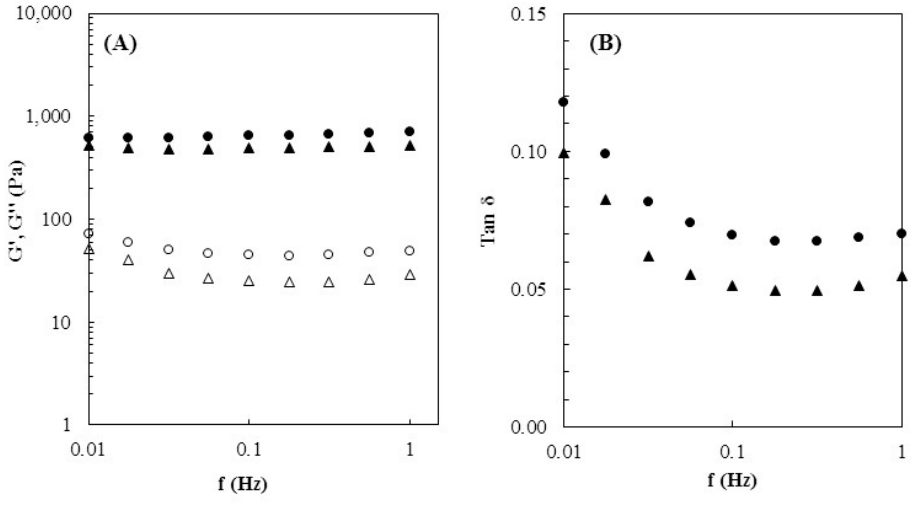
Figure 4. Rheological properties of the Na5 1 * 4 ( ) and Na5 1 * 6 ( ) hydrogels at 25 °C: ( A ) Mechanical spectrum storage (G ′ , solid symbols) and loss moduli (G ″ , open symbols), ( B ) loss tangent (tan δ ). The Na5 1 * 6 hydrogels exhibited higher values of both G ′ and G ″ across the entire range of frequencies (Figure 4A), which can be related to their higher polymer content. For a frequency of 1 Hz, the Na5 1 * 6 hydrogels presented a G ′ of 702.25 ± 28.65 Pa, while lower values were reached for the Na5 1 * 4 hydrogels (523.20 ± 21.08 Pa), as well as for the Na5 1 * hydrogels (149.9 ± 9.8 Pa) [24]. This behavior can be explained by the denser cross- linked structure the Na5 1 * 6 hydrogels formed (Figure 1C) due to the higher polymer con- centration and has been reported for other CGC-based hydrogels. An example are the hydrogels prepared with Ganoderma lucidium CGC dissolved in ionic liquids [39], for which the authors reported a gel strength increase (from ~3500 to ~7000 Pa, at 1 Hz) by increasing the polymer concentration from 4 to 6 wt%. The viscoelastic behavior of CGC hydrogels was also determined by the value of the loss tangent of delta (tan δ ), which represents the ratio of energy lost to energy stored during deformation. As shown in Figure 4B, both hydrogels exhibited tan δ values below 1, which confirms the elastic characteristics of CGC hydrogels [40]. Moreover, it can be observed that by increasing the frequency a decrease in the tan δ values was achieved, and for both hydrogels, a plateau was reached. This behavior is associated with the mostly frequency-independent performance of both moduli (Figure 4A). Similar behavior was reported for chitosan-based hydrogels [41]; however, those structures were weaker than CGC hydrogels since higher tan δ values (above 0.15) were obtained. Over the whole range of frequencies, the Na5 1 * 4 hydrogels presented lower tan δ values (0.049–0.100) com- pared to Na5 1 * 6 hydrogels (0.067–0.118). The results indicate that during deformation, Na5 1 * 4 hydrogels have more elastic characteristics, which give them a higher ability to store energy than to dissipate it. These findings are in accordance with the mechanical properties and revealed that increasing the polymer content led to the fabrication of more rigid hydrogels. 3.5. Swelling Ratio and Water Retention Behavior The swelling ability of CGC hydrogels was assessed by immersing freeze-dried hy- drogel samples (Figure 5A) in three different media (deionized water, PBS, and NaCl 0.9%) at 37 °C, for 10 min (Figure 5B). Macroscopically, after freeze-drying, the structures’ dimensions were retained (Figure 5A), showing that the polymer network was not signif- icantly affected by water removal. Moreover, the structures presented a lighter yellowish coloration and were rigid. Upon rehydration, in spite of the similar dimensions, hydrogels exhibited a whitish color and became opaque (Figure 5B).